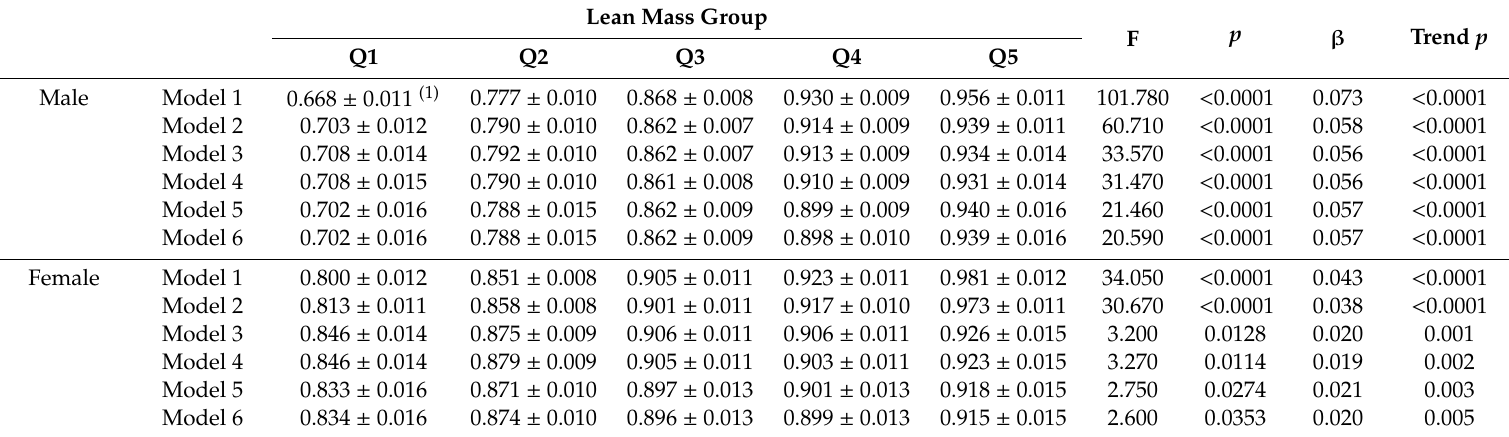
Table 5. Analysis of the bone density (total lumbar spine) di ff erences of lean mass